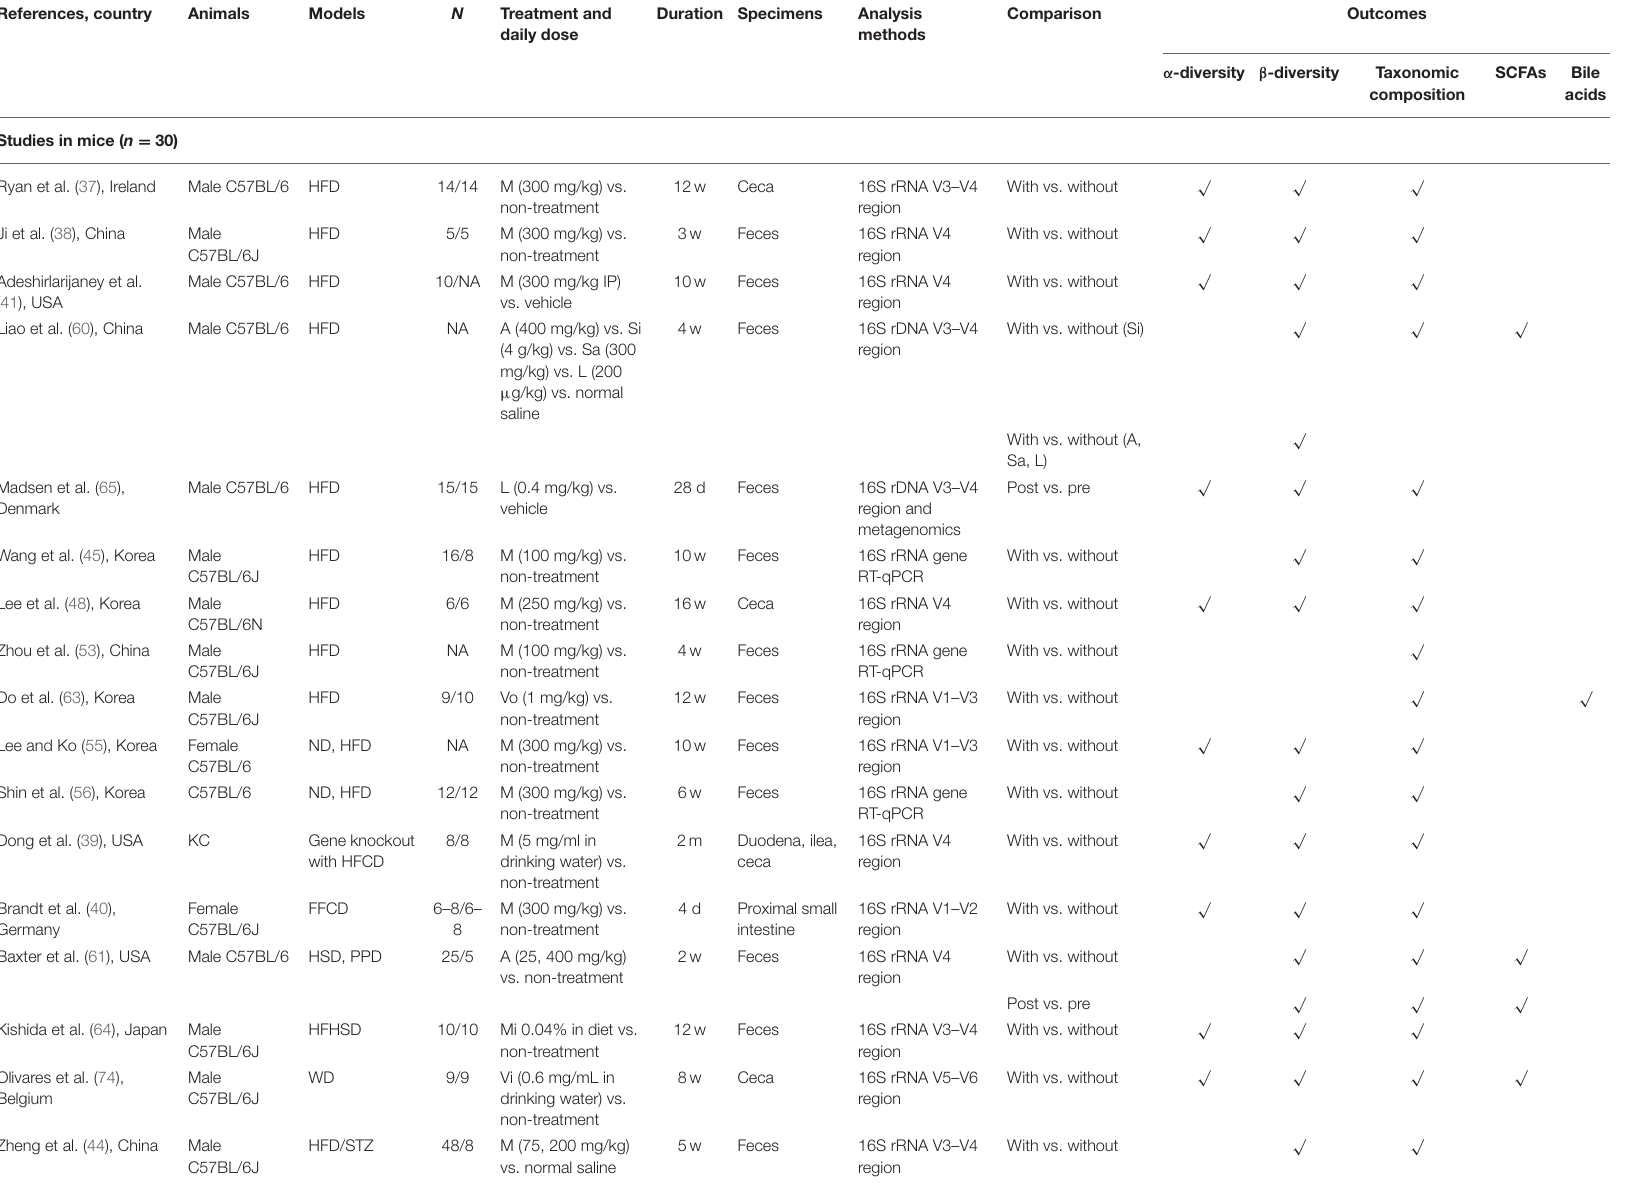
drinking water) vs. non-treatment M (75, 200 mg/kg) vs. normal saline